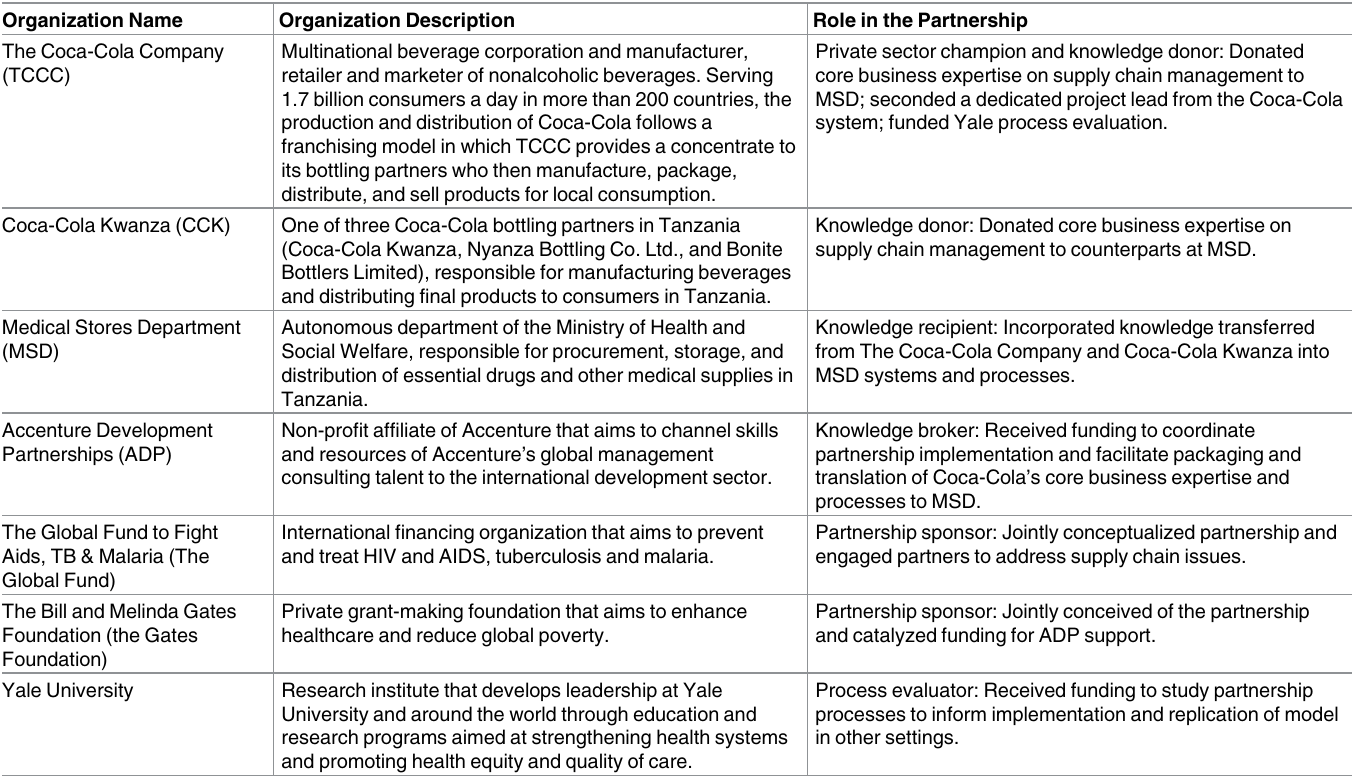
Table 1. Partner organizations.